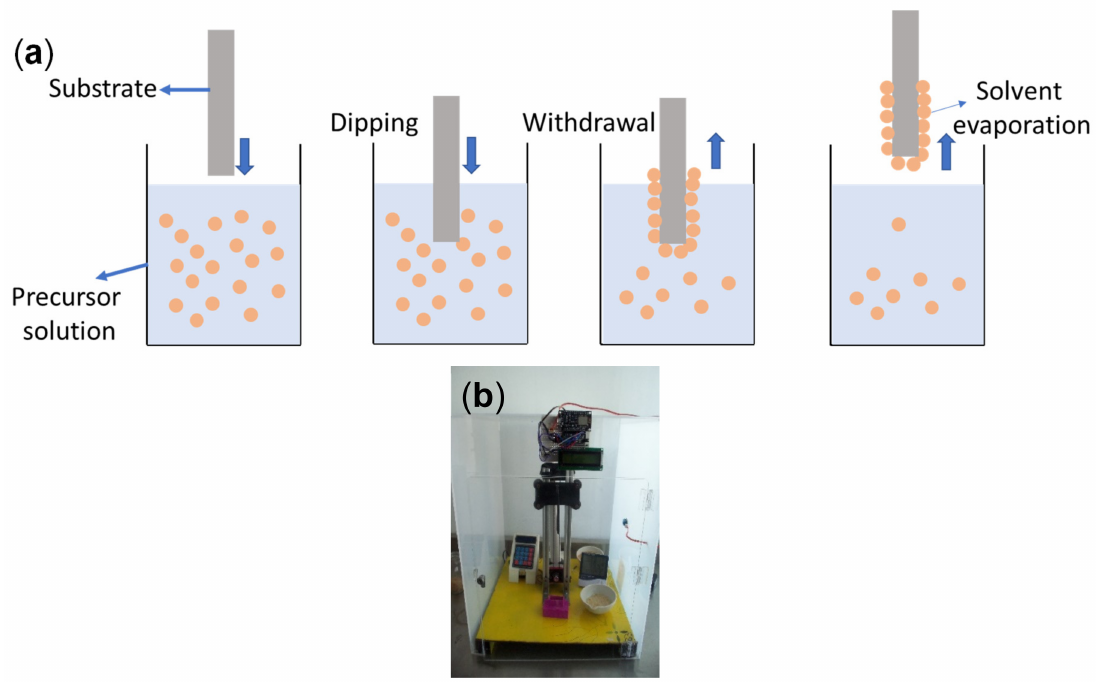
Figure 1. ( a ) Sequential steps of the sol–gel dip-coating method for thin film deposition. ( b ) Dip coating system assembled in the NanoBiotechnology and Photocatalysis Laboratory—UAQ. This system is used for the production of various thin